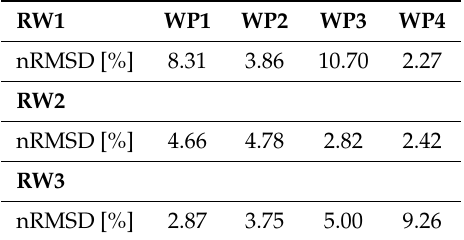
Table 4. nRMSD between the experimental and numerical free surface elevation, for waves RW1–RW3. RW1 WP1 WP2